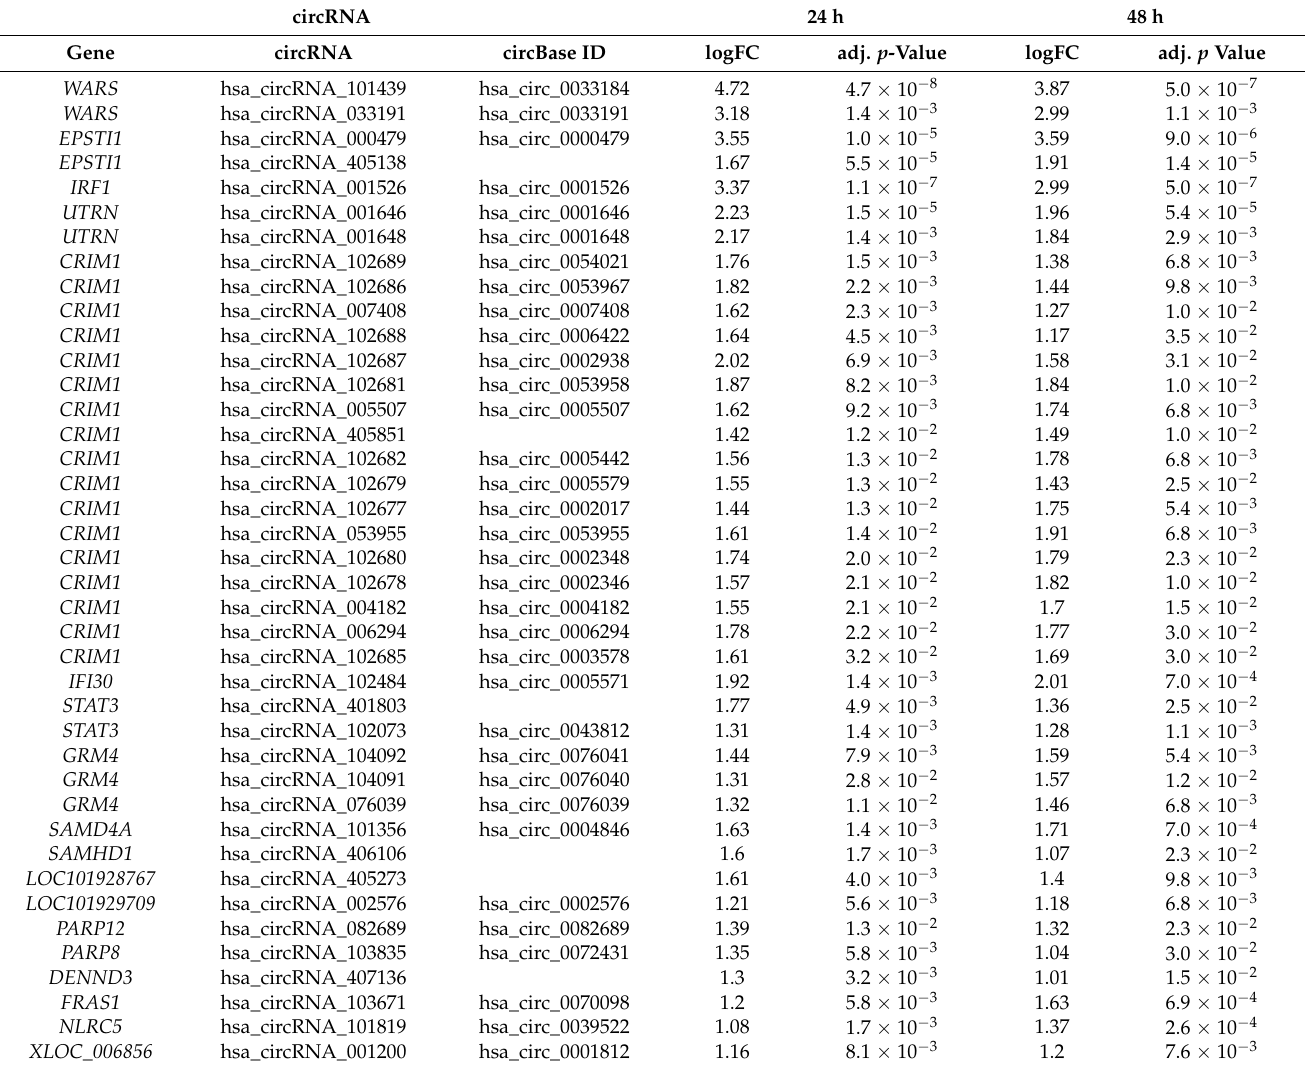
Table 1. Upregulated circRNAs after cytokine exposure at both 24 h and 48 h in human EndoC- β H1 cells. The table shows 40 circRNAs upregulated at both 24 and 48 h. The circRNA array IDs and the circBase IDs (wherever available) are shown for all candidates, along with their log fold changes and adjusted p